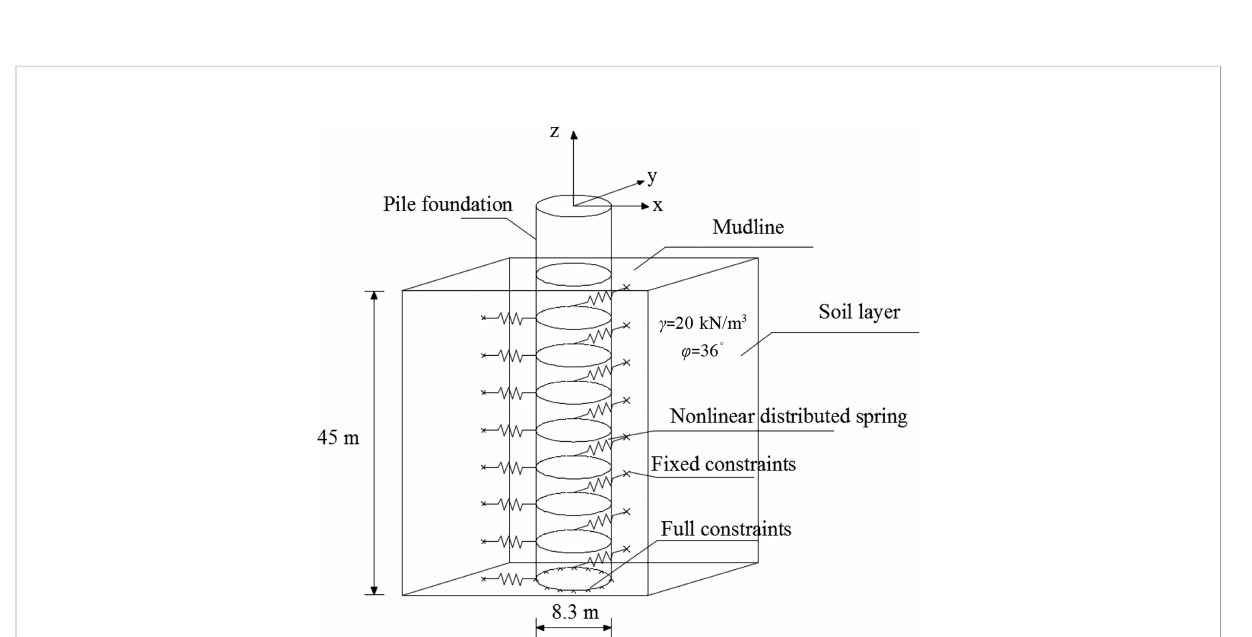
FIGURE 7 Pile – soil interaction model based on nonlinear distributed springs.